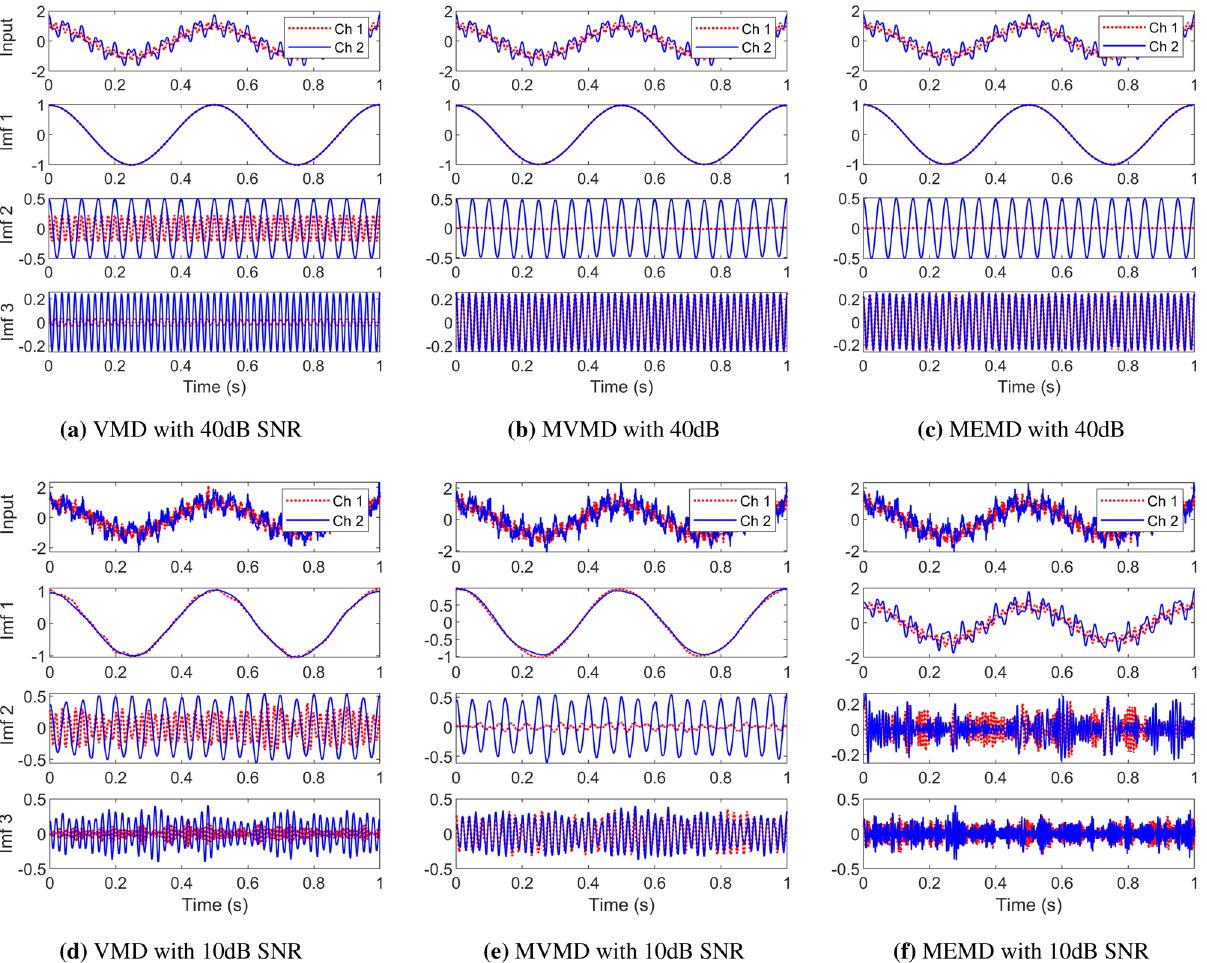
Figure 6. Signal decomposition of noisy multivariate synthetic signals, corresponding to the SNR = 40 dB (top row) and SNR = 10 dB (bottom row) with white Gaussian noise, obtained by applying the VMD (channel-wise), MVMD and BEMD